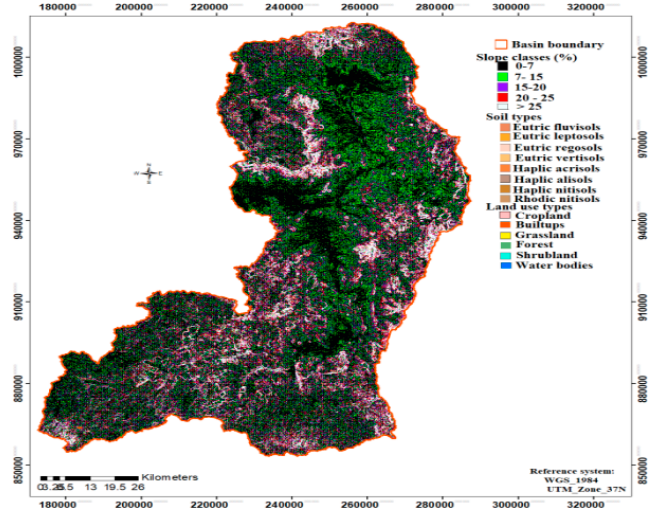
Figure 6. Hydrologic response units formed by overlay of slope, soil and LULC layers.